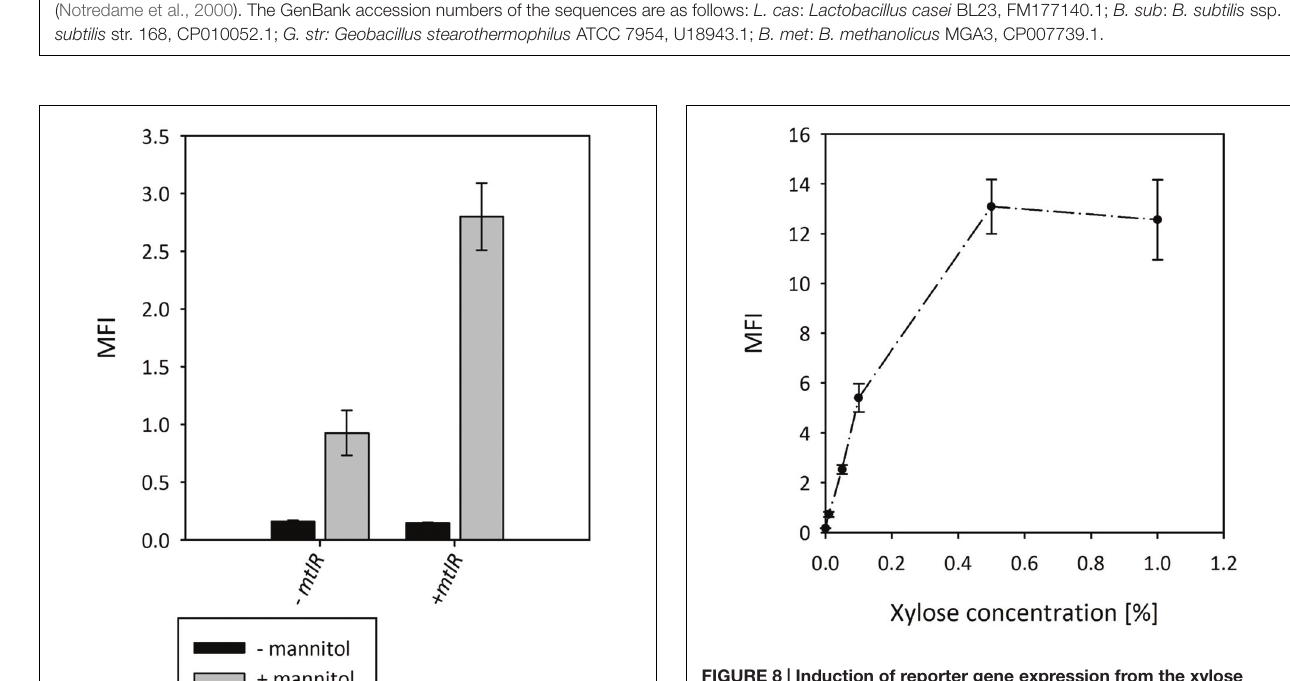
FIGURE 8 | Induction of reporter gene expression from the xylose inducible promoter of pTH1xpx- gfpuv . MFI − median fluorescence intensity of GFPuv given in a.u. GFPuv fluorescence of exponentially growing cells was measured after 2 h incubation at 37 ◦ C and 200 rpm. Mean values and standard deviations of triplicate shake flask cultures are